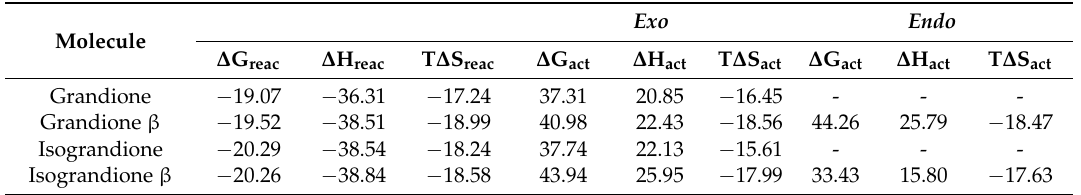
exergonic, with a similar energy reaction fluctuating from − 20.29 kcal/mol (isograndione) down to − 19.07 kcal/mol (grandione). Table 1. Relative enthalpies, entropies, and Gibbs energies (kcal/mol) for the stationary points involved in the DA reactions at 298.15 K and 1 atm in